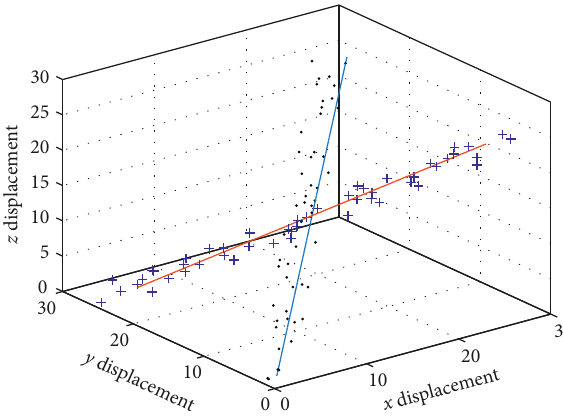
Figure 8: 3D fitting curve of control points and check points in image sequence.